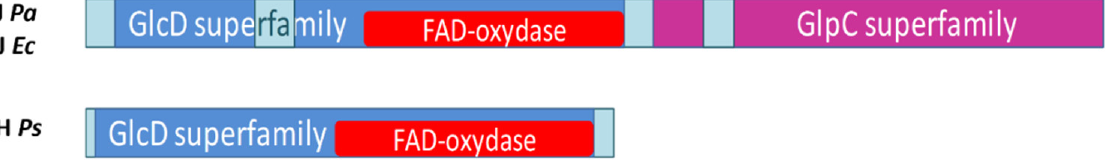
Figure 4. Multiple sequence alignment of the first 542 residues (GlcD superfamily, FAD oxidore- ductase domain) of YdiJs (D2HGDHs) of P. ananatis (Pa) and E. coli (Ec) with the whole sequence of D2HGDH of P . stutzeri (Ps). The alignment was drawn with ESPRIPT 3.0. 3.2. Determination of Physiological Function of YdiJ In Vivo To determine the in vivo function of YdiJ in E. coli and P. ananatis , we inactivated the corresponding genes, resulting in E. coli strain MG1655 Δ ydiJ ::Km and P. ananatis strain